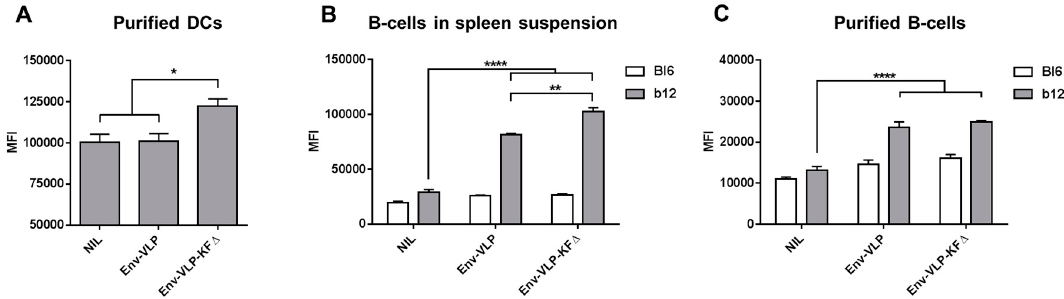
Figure 2. Activation of dendritic cells (DCs) and cognate B-cells with Env-VLP-KF ∆ nano-vaccines. ( A ) DC, ( B ) splenocyte, or ( C ) B-cell suspensions from wild-type (wt) Bl6 or BCR-transgenic b12 mice were incubated for 24 h in the presence of same amounts of either Env-VLP or Env-VLP-KF ∆ . After incubation, the cells were stained with anti-CD11c ( A ), anti-B220 ( B , C ), and anti-CD86 ( A – C ) antibodies and analyzed with flow cytometry. Data are depicted as mean fluorescent intensity (MFI) of anti-CD86 antibody staining for CD11c + DC cells ( A ) and B220 + B-cells ( B , C ). Data are presented as the means ± SEM of three independent experiments. * p < 0.05; ** p < 0.005; **** p < 0.0001; one-way ANOVA with Tukey multiple comparison post-hoc test.